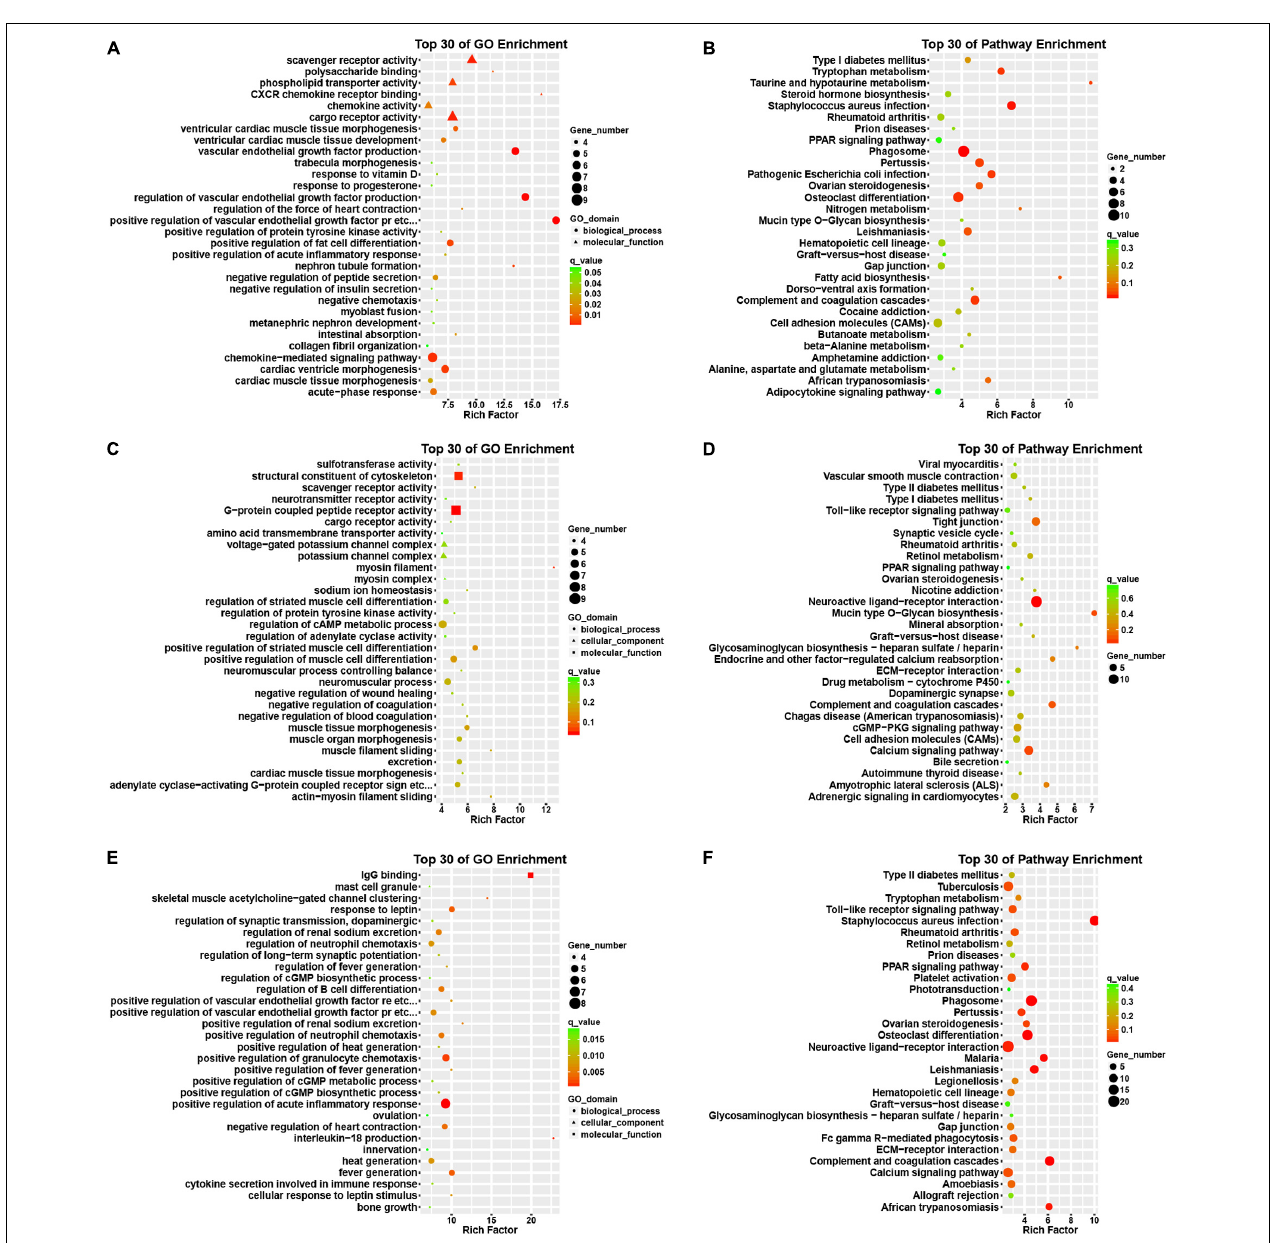
FIGURE 3 | Bioinformatics analysis of DEGs among normal, paroxysmal AF and persistent AF samples. (A,B) GO and KEGG pathway analysis of DEmRNAs in paroxysmal AF compared to normal samples. (C,D) GO and KEGG pathway analysis of DEmRNAs in persistent AF compared to normal samples. (E,F) GO and KEGG pathway analysis of DEmRNAs in persistent AF compared to paroxysmal AF